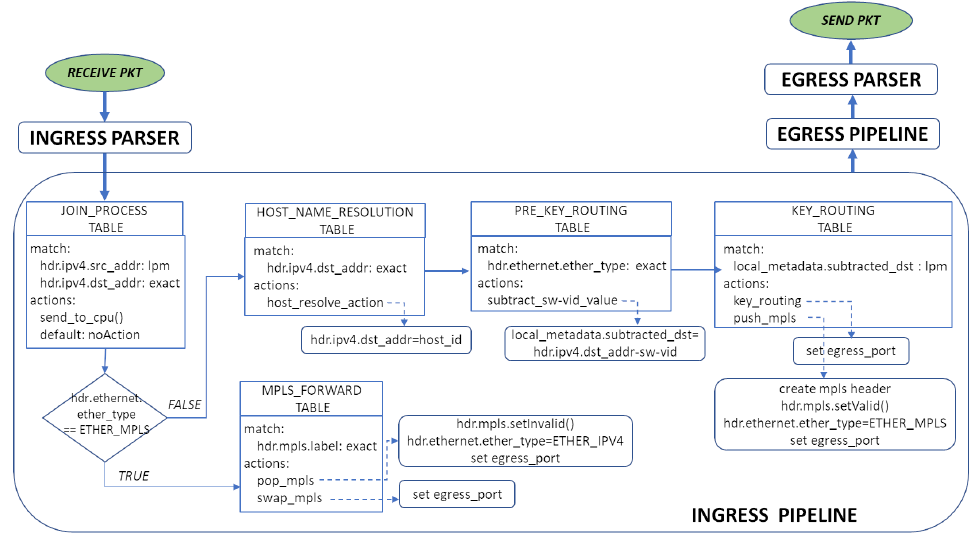
Figure 8. “Translation of ranges solution”: Tables and actions in the ingress